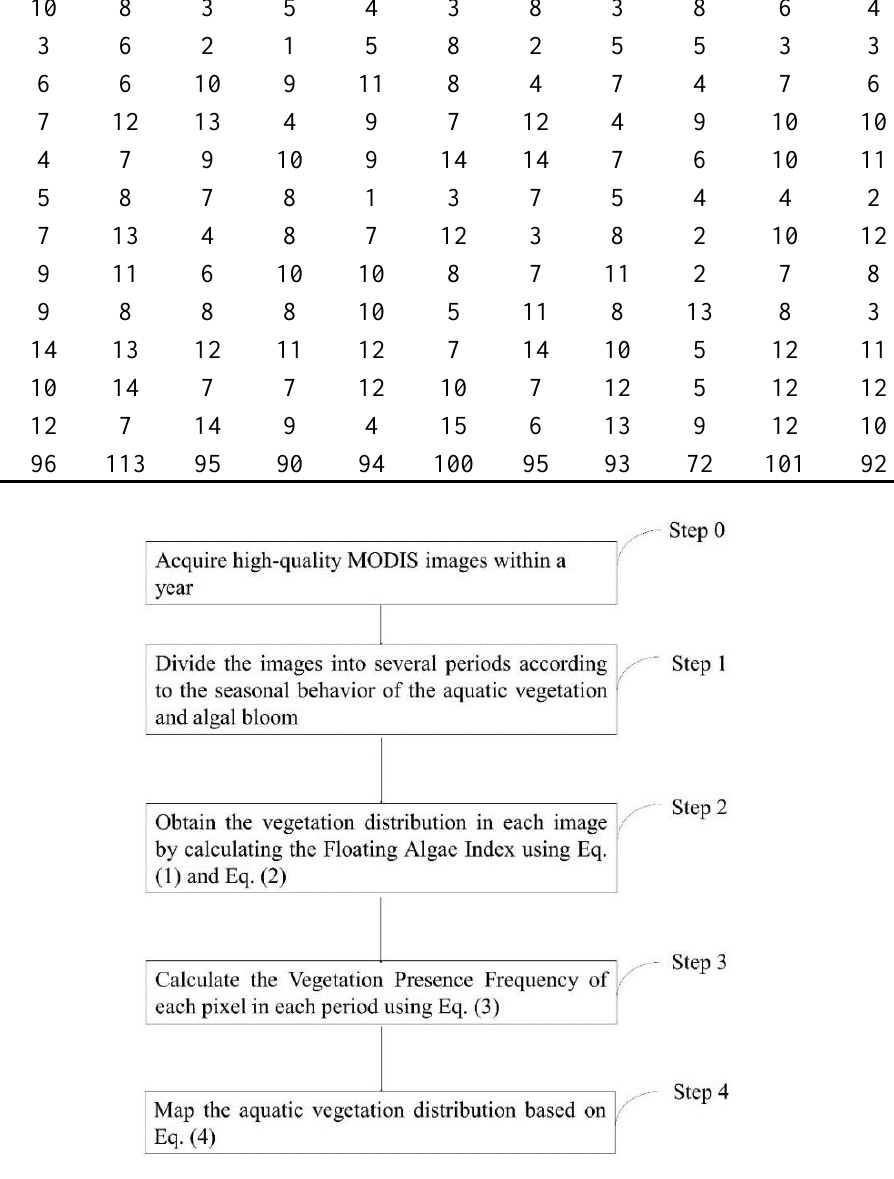
Figure 3. Flow chart of the general